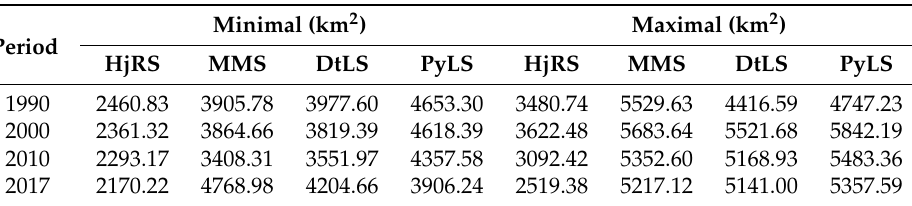
Table 5. Minimal and Maximum Surface water extent in the four sub-basins of the MYRB in the study periods.